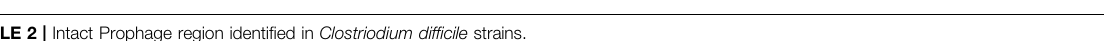
TABLE 2 | Intact Prophage region identi fi ed in Clostriodium dif fi cile strains. Genome